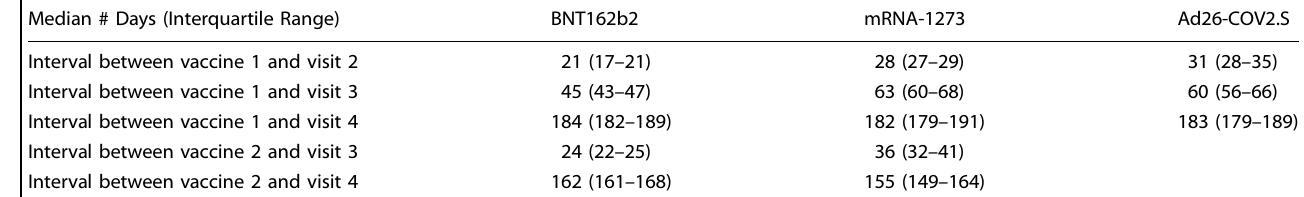
Table 2. Intervals between vaccination and follow up visits for each vaccine group.